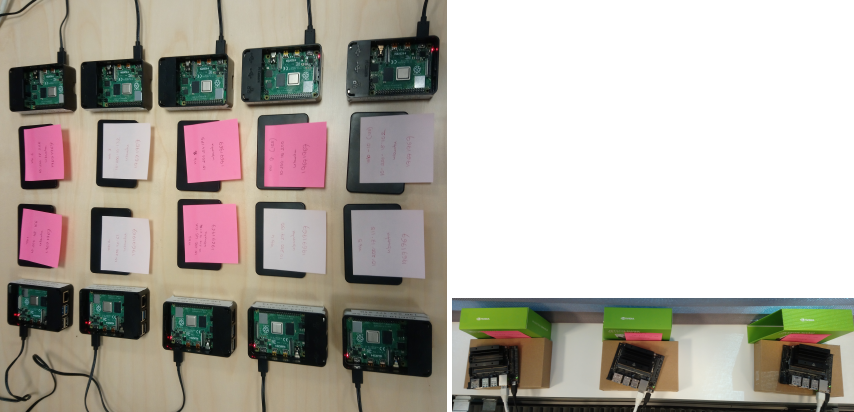
Figure 4. Raspberry Pi ( left ) and Jetson Nano ( right ) edge devices used in the